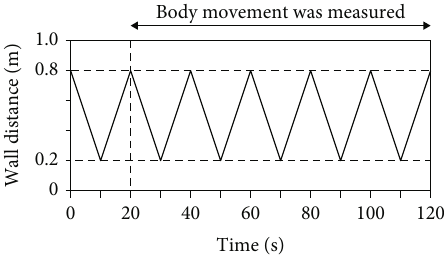
Figure 2: Wall movement presented to the participants. The wall reciprocated (approached and receded) six times at a linear distance of between 0.2 and 0.8m in front of each participant within a 20s period. The body movements were measured during the last fi ve